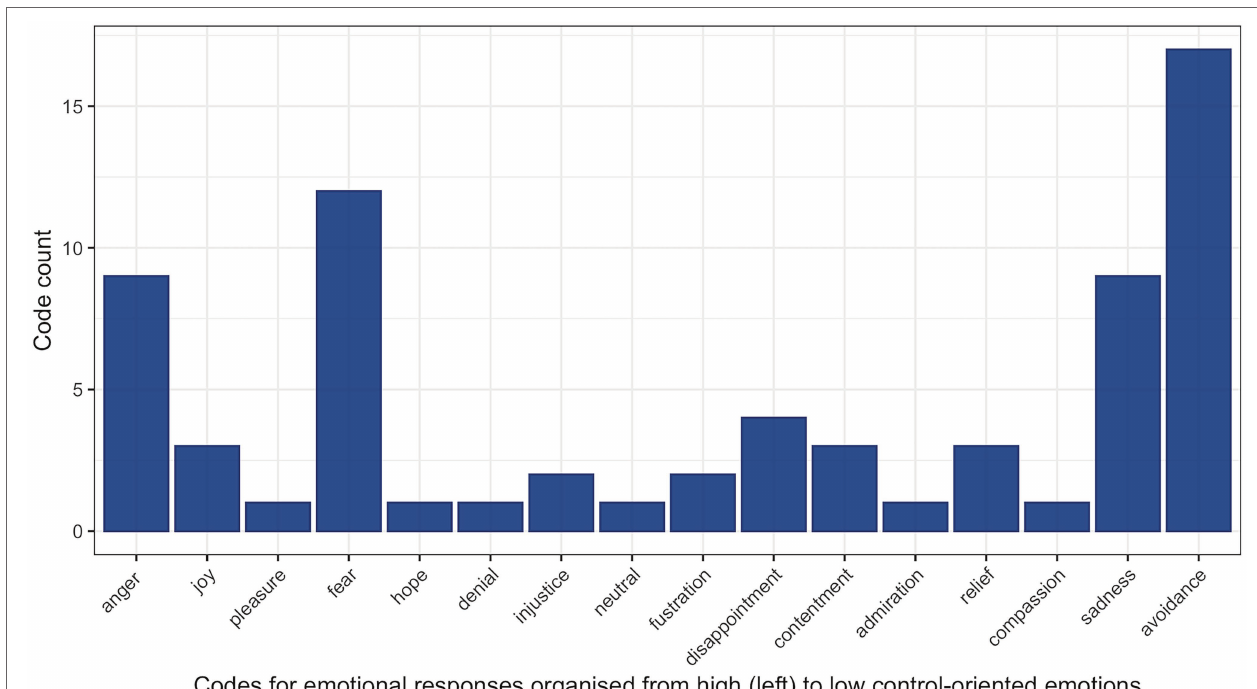
FIGURE 1 | Count for each emotion